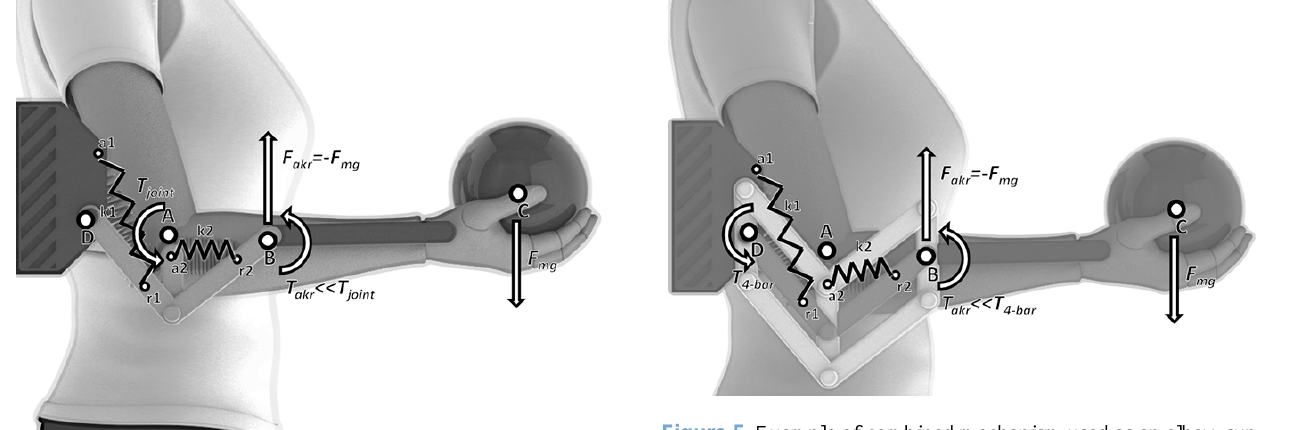
Figure 5. Example of combined mechanism used as an elbow sup- port exoskeleton. The user’s elbow join is located at A, a load is applied at point C, and point B is located arbitrarily along the line AC. All forces supplied by the mechanism are explicit. Compensa- tion case illustrated is for 100% compensation. Residual forces left to the operator at point A can be controlled to appropriate